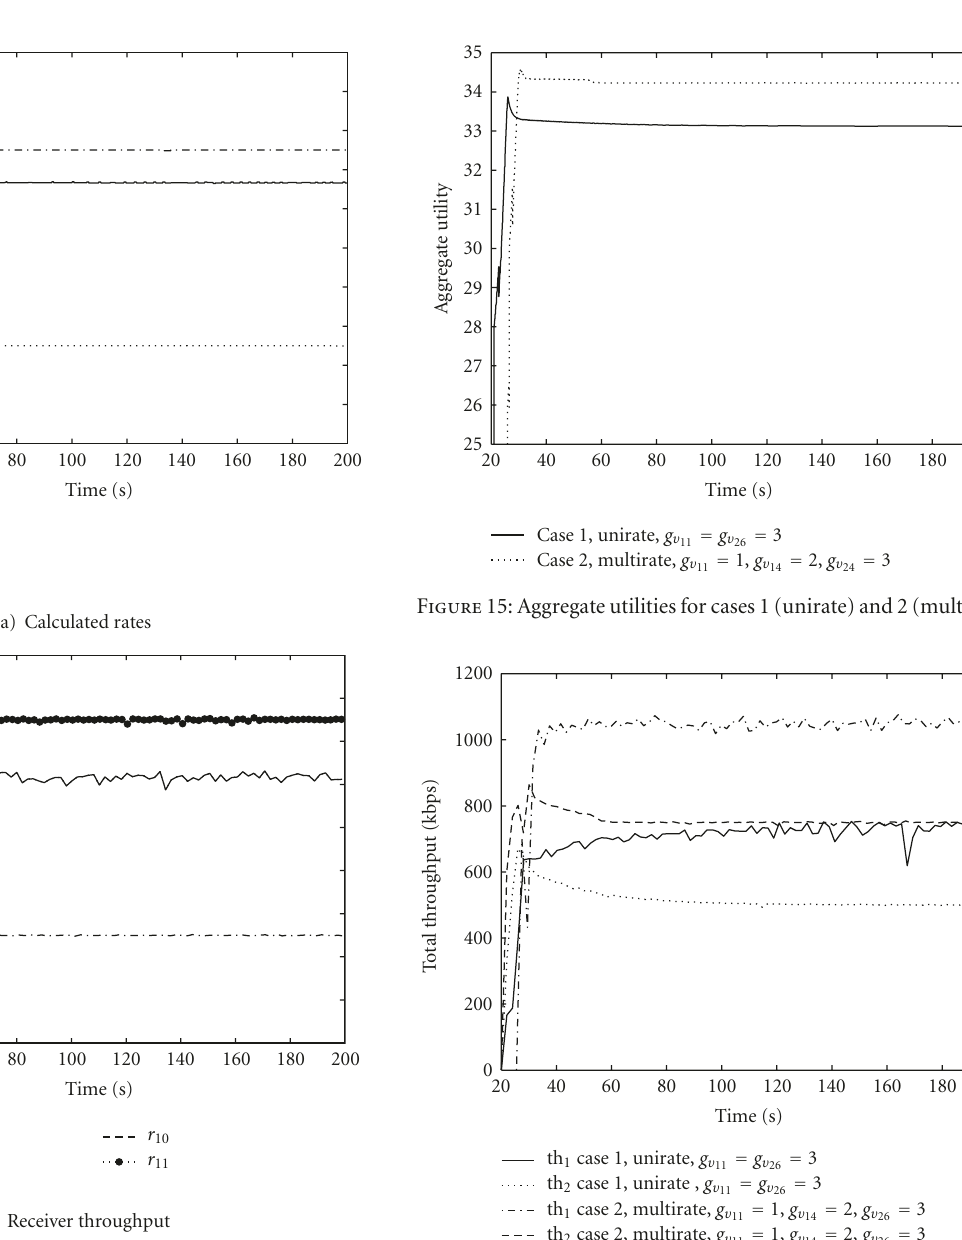
Figure 16: Total throughput for each multicast group for cases